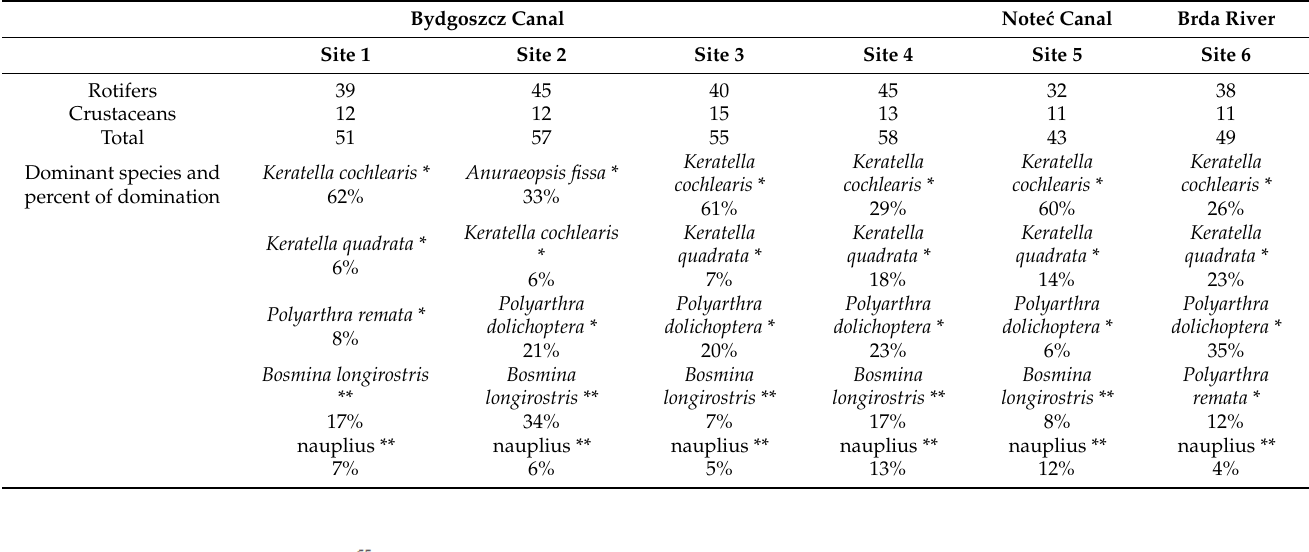
Table 2. Total number of species (diversity) and dominants in the zooplankton community during growing season 2019 in the Bydgoszcz Canal, the Note´c Canal, and the Brda River sites (* Rotifer, ** Crustacean).